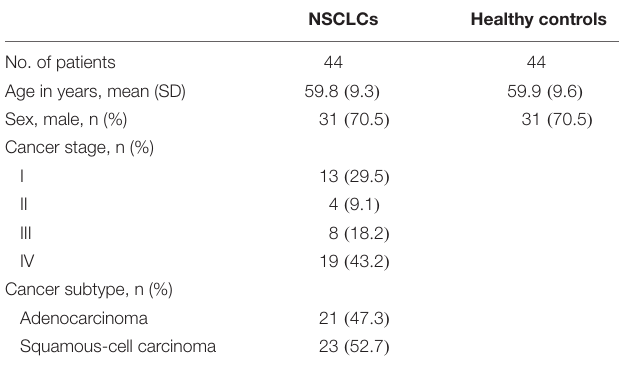
TABLE 1 | Clinical characteristics of the patients with NSCLC and healthy